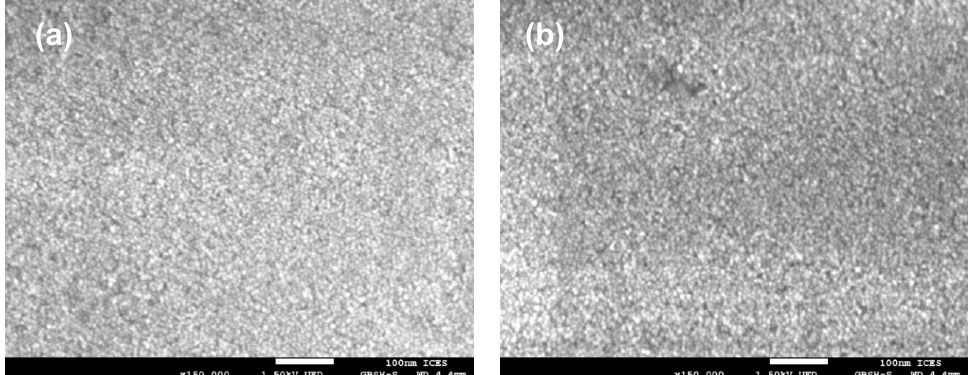
Figure 4. Scanning electron micrographs of ( a ) pristine OF50 and ( b ) OF50-M.